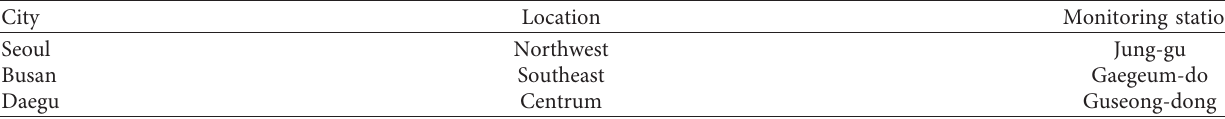
Table 1: Information of cities in the sample.